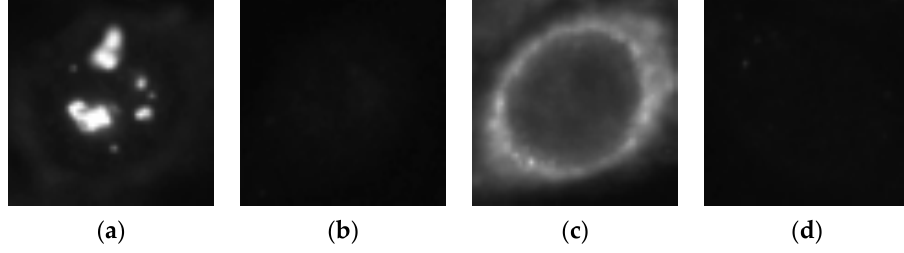
Figure 1. HEp-2 cellular images from the 13A dataset. ( a ) A positive intensity nucleolar cell; ( b ) a negative intensity nucleolar cell; ( c ) a positive intensity nuclear membrane cell and ( d ) a negative intensity nuclear membrane cell.